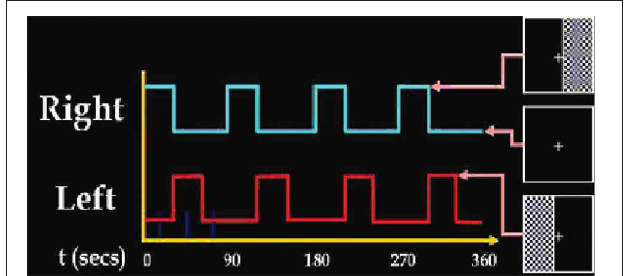
FIGURE 1 | Summary of the stimulus set-up presented to the subject during experiment data